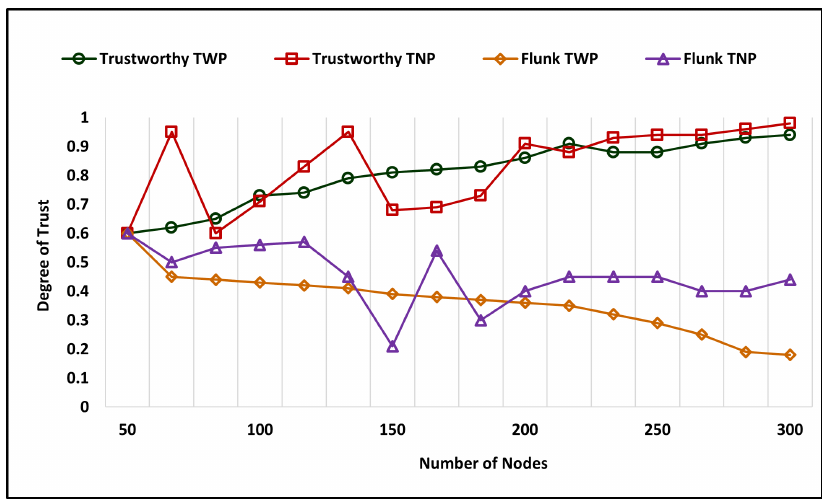
Figure 3. The impact of aggregated trust computation.